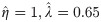
Parameter retrieval for multiple-hitting CTLs with underlying hitting delay.A) Estimated parameters (points), compared to the underlying parameter values used (red lines) in CPM simulations, featuring high-motility CTLs, in which we varied the lower bound for the time (in minutes, as indicated) needed for hitting. B) Kaplan-Meier survival functions (black lines), or survival functions plotted with estimated parameters fitted to data from Nw = 100 CPM simulations generated by multiple-hitting (lower row, ηCPM = 2) or single-hitting CTLs (upper row, ηCPM = 1). C) Heatmaps from one CPM simulation containing high-motility, single-hitting CTLs who had a 15 minute lower bound set on the hitting time. Each row represents a single target. Target status is represented by colour: targets not-contacting the CTL are deep purple, and killed targets are grey. Contacted targets are coloured according to their momentary hazard according to two candidate parameter sets (top panel: η^=1,λ^=0.65; bottom panel: η^=2,λ^=1.65). D) Predicted killing rate according to two different candidate parameter sets (η^=1, red lines; η^=2, blue lines), candidates being themselves applied to CPM simulations with high-motility, +15m CTLs (ηCPM = 1, top panel; ηCPM = 2, bottom panel).